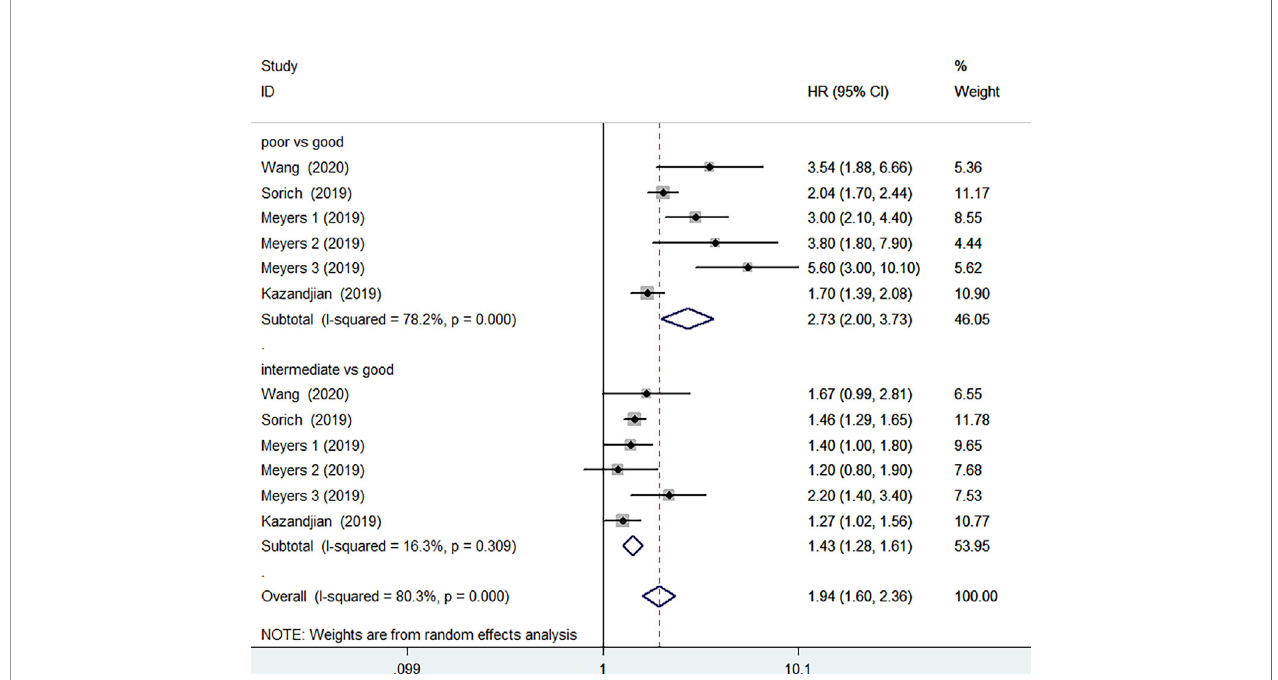
FIGURE 3 | Meta-analysis of PFS in cancer patients after ICIs treatment (poor LIPI score groups vs. good LIPI score groups, intermediate LIPI score groups vs. good LIPI score